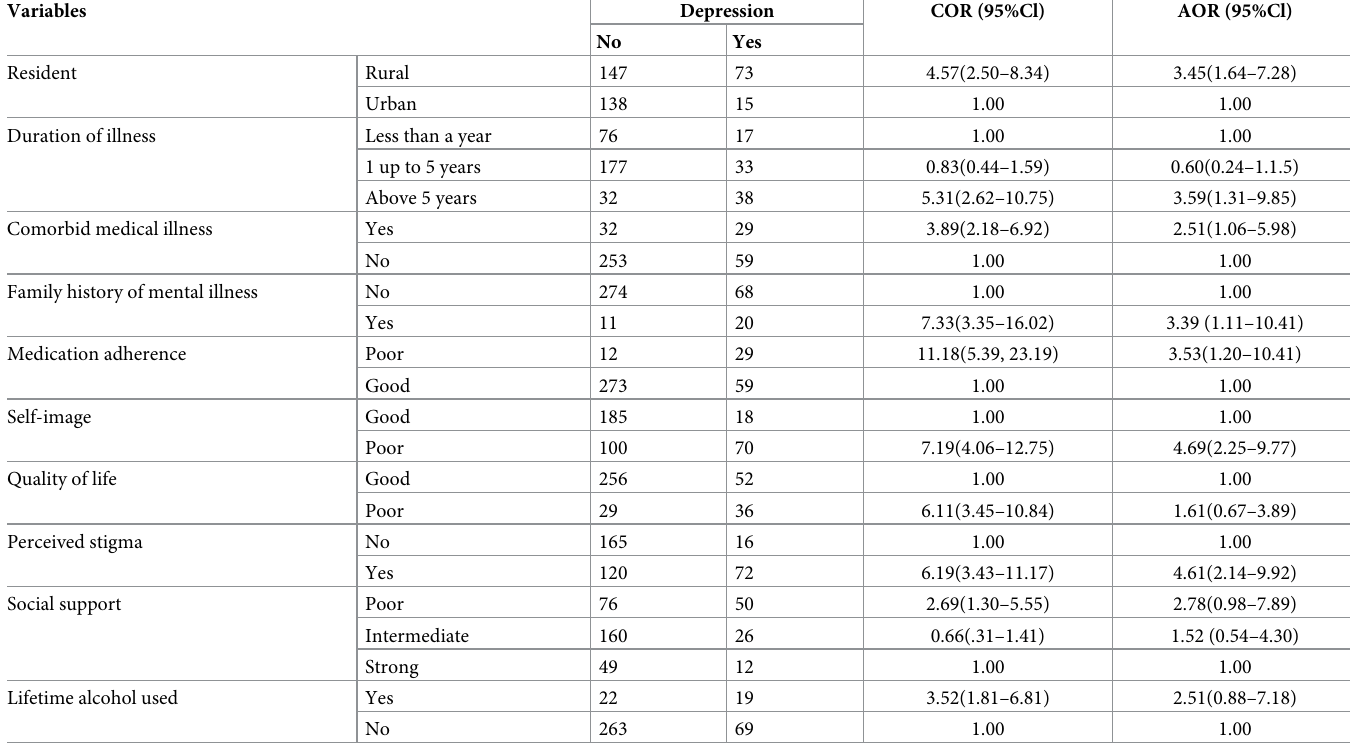
Table 3. Bivariate and multivariable logistic regression: Factor associated with depression among people with chronic skin disease attending at Boru Meda Hospi- tal, Northeast Ethiopia (N =